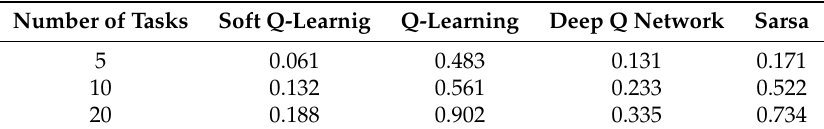
Table 2. The sparse degree of Q